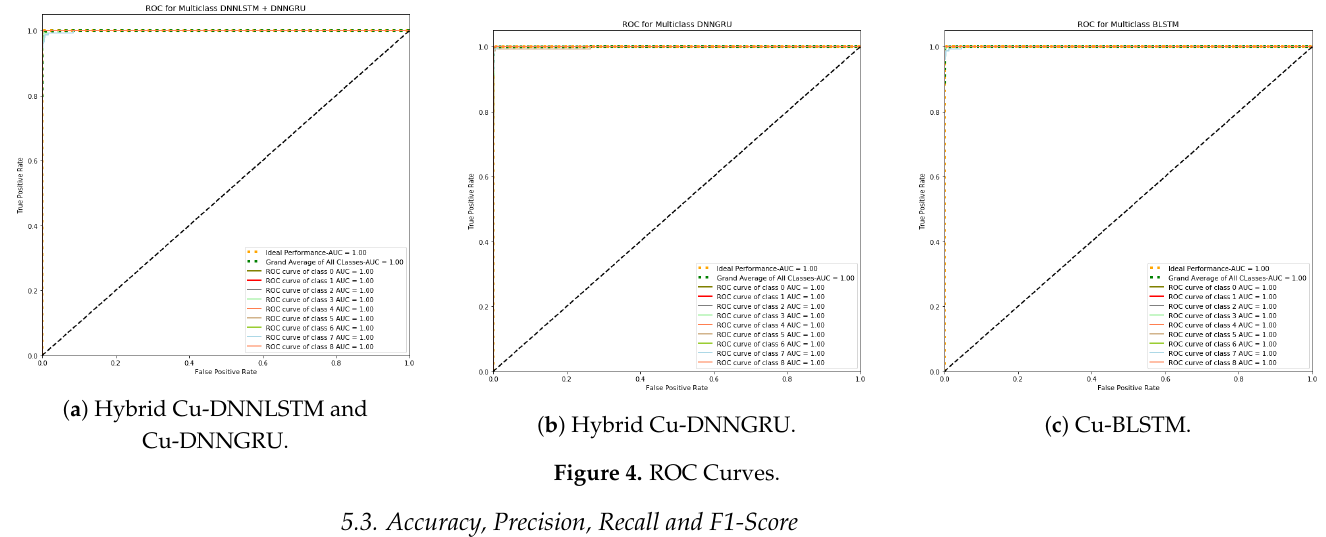
Figure 4. ROC Curves.